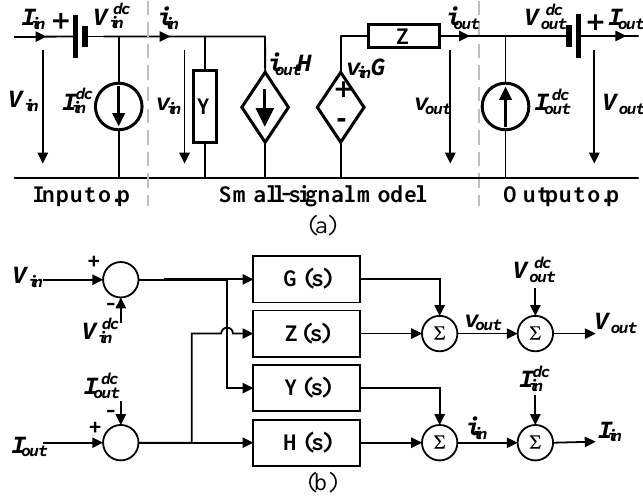
Figure 1. G-parameters model. ( a ) Equivalent electrical circuit, ( b ) Block diagram